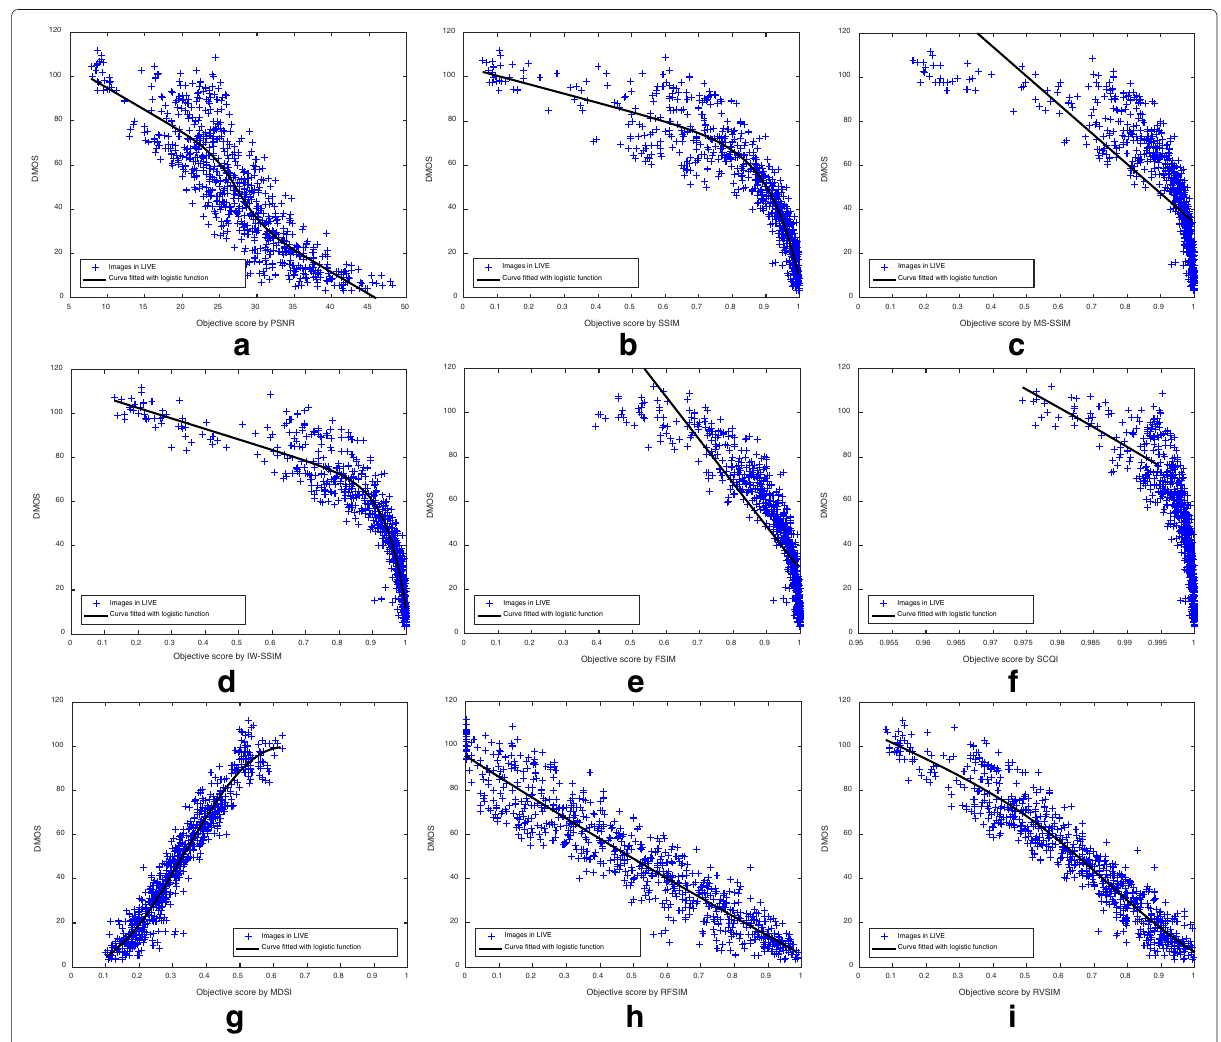
Fig. 8 Scatter plots of predicted image quality indices on the LIVE database. a PSNR, b SSIM, c MS-SSIM, d IW-SSIM, e FSIM, f SCQI, g MDSI, h RFSIM, and i RVSIM